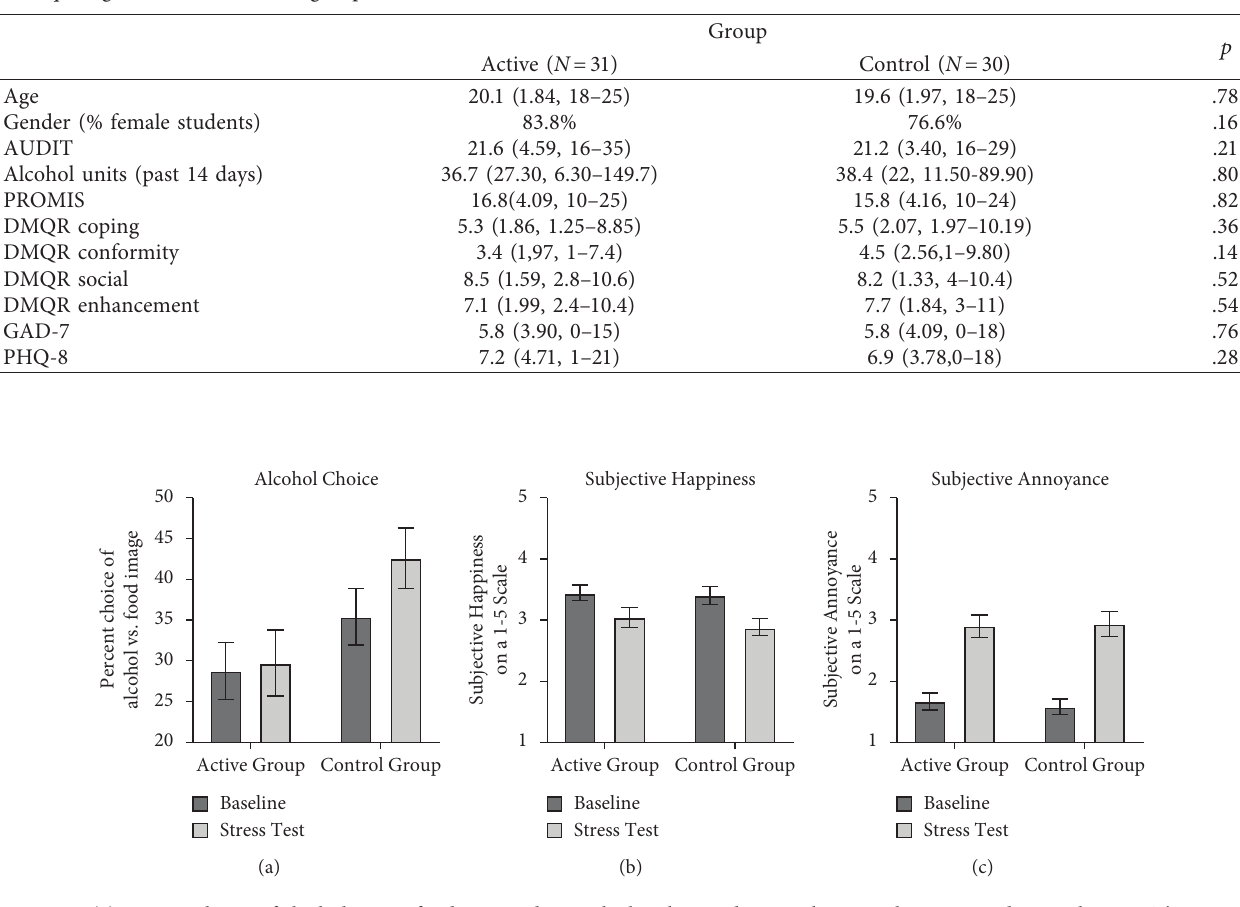
Figure 1: (a) Percent choice of alcohol versus food images during the baseline and stress phases in the active and control group. The active intervention abolished the stress-induced increase in alcohol choice found in the control group. Subjective happiness (b) and annoyance, (c) immediately following the baseline and stress choice phases in the active and control group. Stress induction worsened subjective mood but the intervention manipulation did not modify these effects. Error bars in this figure represent standard (1, 59) � .04, p � . 82, η 2 � . 00, or interaction between group and time point, F (1, 59) � .22, p � . 63, η 2 � . 00. These